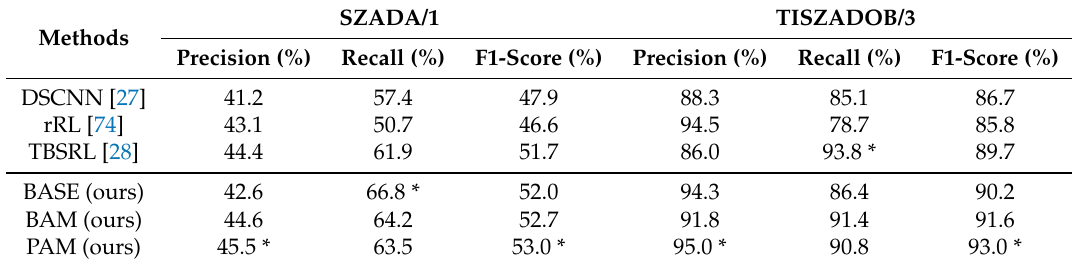
Table 6. Comparisons of different methods on SZTAKI dataset.